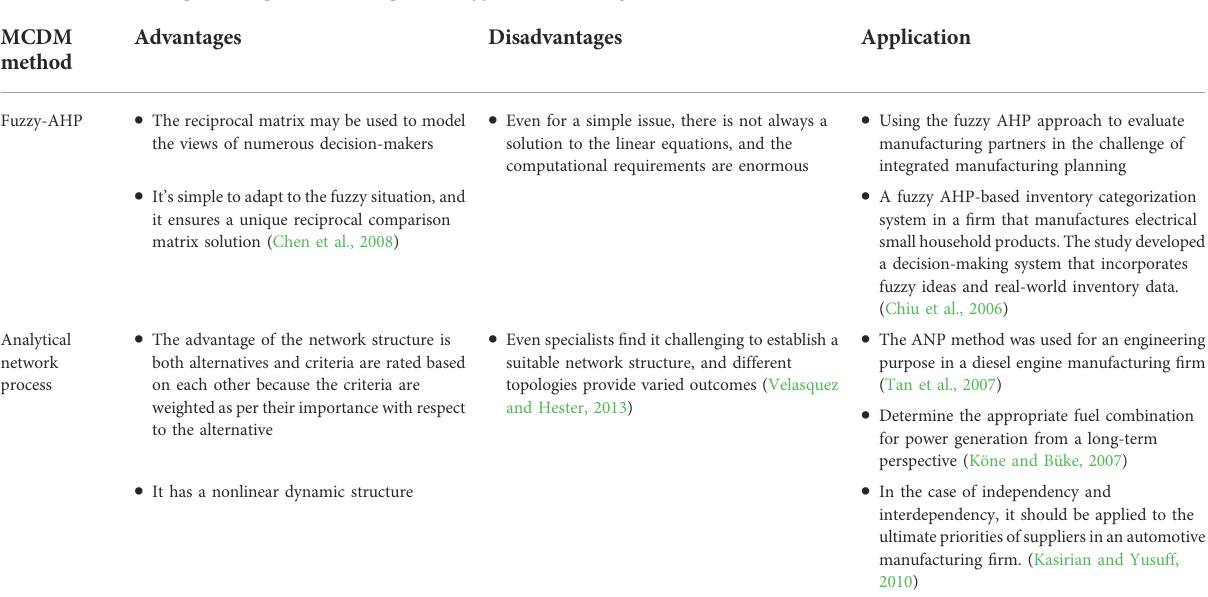
TABLE 1 Table showing advantages, disadvantages, and application of Fuzzy-AHP